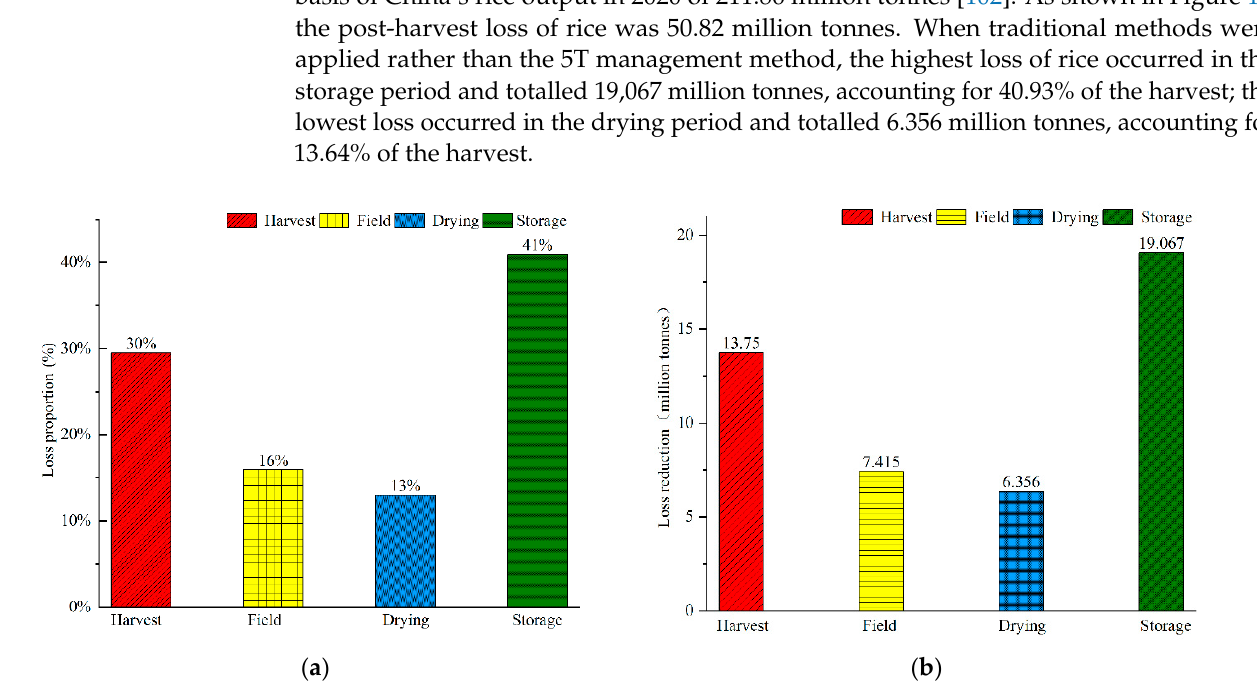
Figure 12. ( a ) Loss proportion and ( b ) loss reduction in rice in different periods.